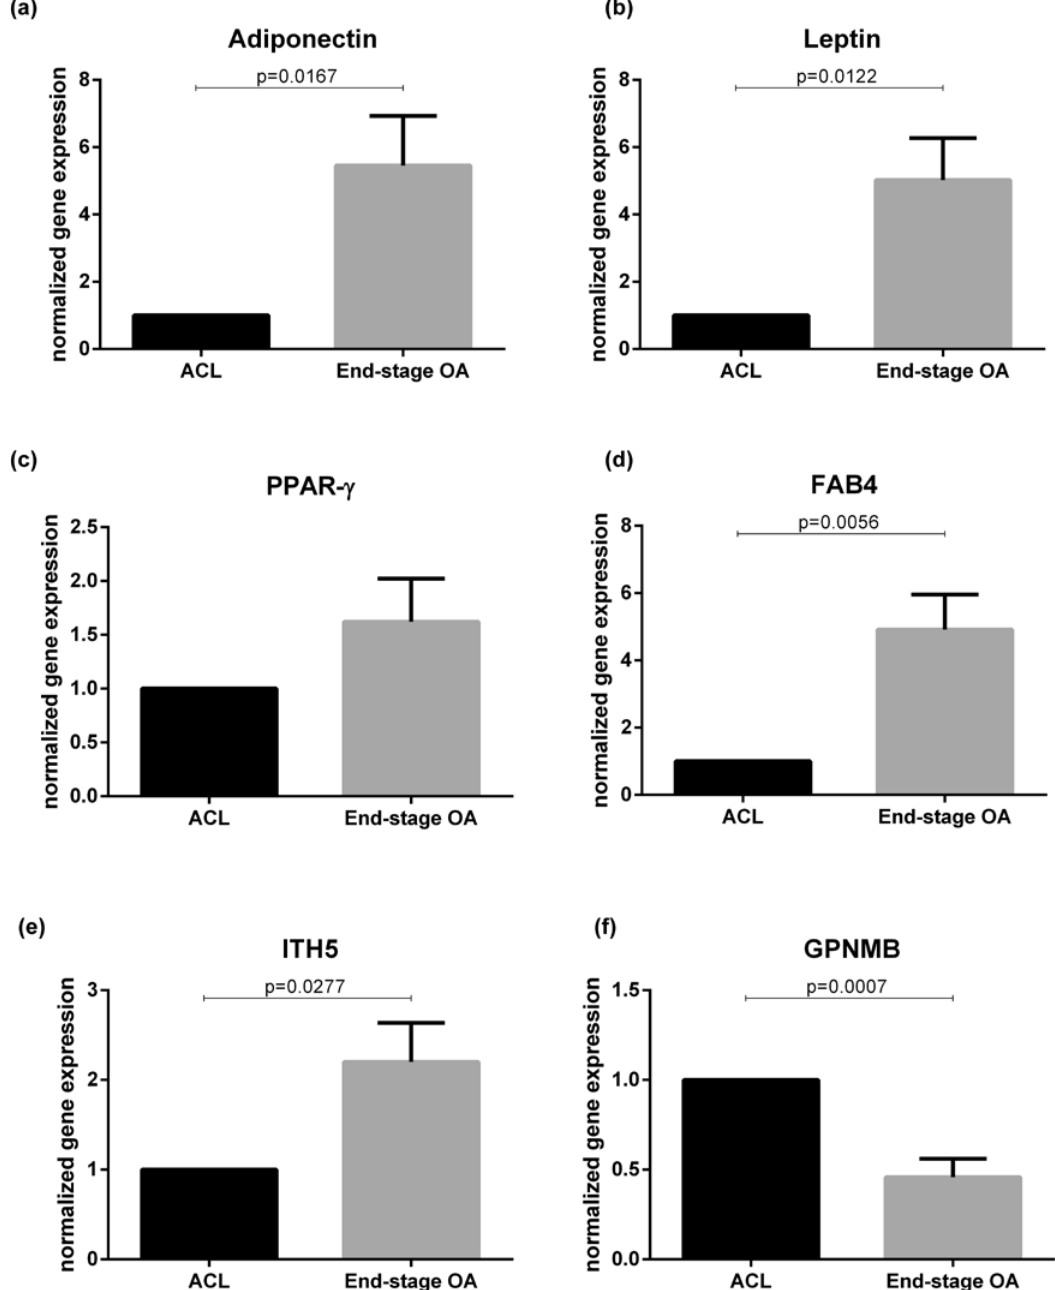
Figure 3. Adipokines evaluation in IFP ACL ( n = 8) and end-stage OA patients ( n = 8). ( a ) Adiponectin gene expression levels were increased in end-stage OA compared to ACL IFP. ( b ) Leptin gene expression levels were increased in end-stage OA compared to ACL IFP. ( c ) PPAR- γ gene expression levels were increased in end-stage OA compared to ACL IFP. ( d ) FAB4 gene expression levels were increased in end-stage OA compared to ACL IFP. ( e ) ITH5 gene expression was higher in end-stage OA IFP. ( f ) GPNMB gene expression was higher in ACL IFP. IFP = infrapatellar fat pad; ACL = anterior cruciate ligament; OA = osteoarthritis; PPAR- γ = peroxisome proliferative activated receptor gamma; FABP4 = fatty acid-binding protein 4; ITH5 = inter- α -trypsin inhibitor heavy chain 5; GPNMB = transmembrane glycoprotein NMB.